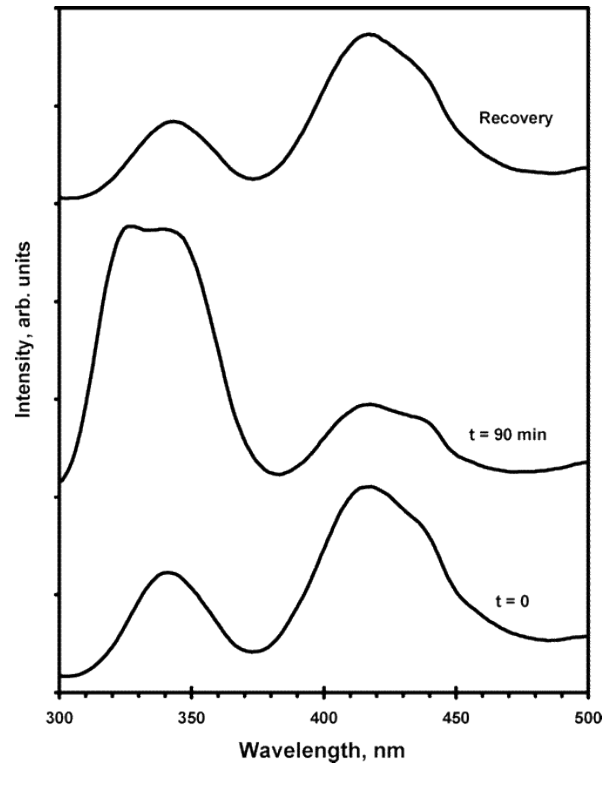
Figure 4. Emission spectra versus 266 nm laser irradiation time at 77 K for batch 1 of [Ag(CN) 2− ]/KCl crystals. All spectra were scanned with 275 nm excitation. Note the dominance of the short-wavelength bands following irradiation at 77 K and the regeneration of the original spectrum in the recovery step. (Reprinted with permission from [39]. Copyright 2000 American Chemical